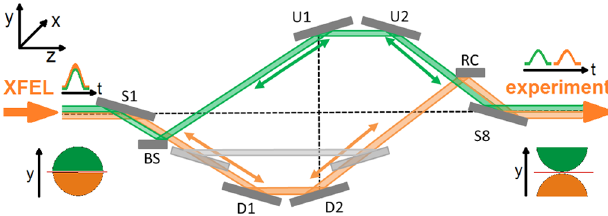
FIG. 1. The optical layout of the SDU for the HED experiment at the SASE2 undulator of the European